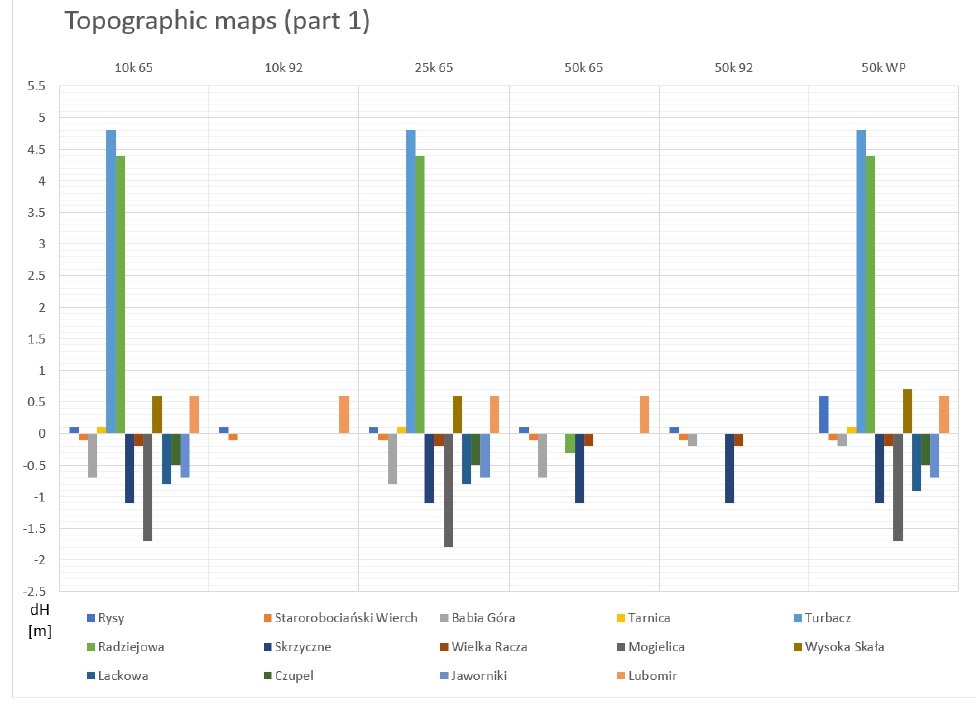
Figure A4. Height difference with GNSS surveying for civil and military topographic maps (Polish and Slovak) (part 1). Source: authors.